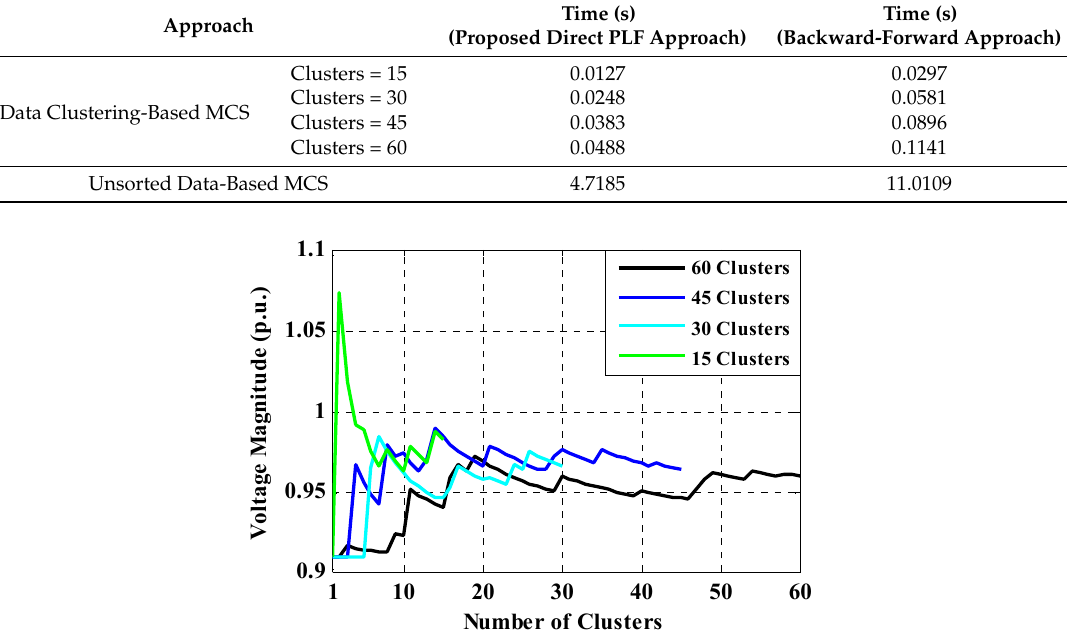
Figure 13. Convergence process of bus-53 for clustering data-based MCS.